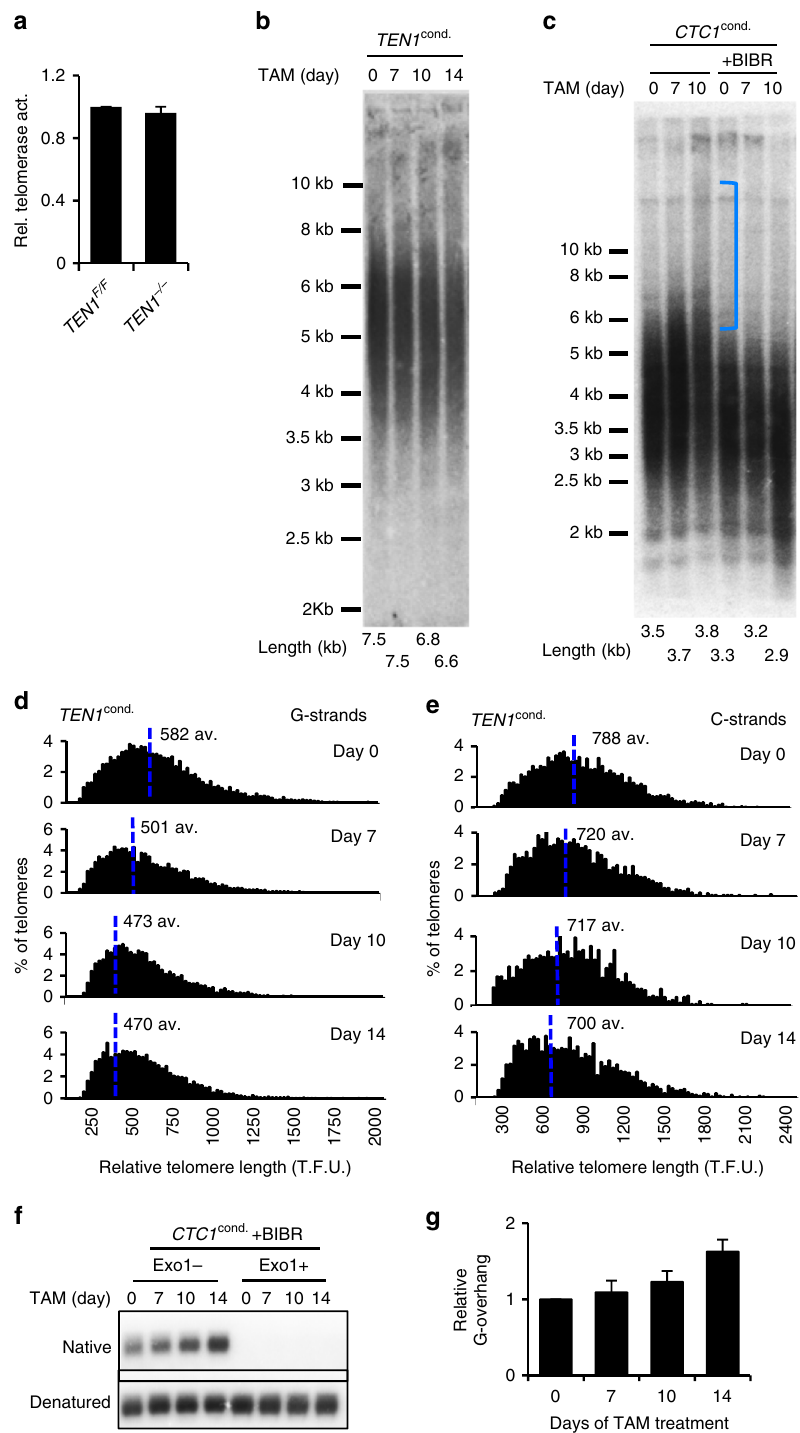
Fig. 3 TEN1 disruption results in telomere shortening without G-strand overextension. a Quanti fi cation of TRAP assay showing telomerase activity in TEN1 conditional cells with/without 14 days tamoxifen treatment. b c Southern blots showing terminal restriction fragments in TEN1 ( b ) or CTC1 ( c ) conditional cells treated with tamoxifen for the indicated times. Mean telomere length is indicated below each lane. c Cells were grown with/or without BIBR1532 for 14 days. Bracket indicates telomere elongation. d e Analysis of telomere length by Q-FISH. Metaphase spreads were hybridized with (C 3 TA 2 ) 3 G-strand probe ( d ) or (G 3 AT 2 ) 3 C-strand probe ( e ). Histograms show distribution of relative telomere lengths expressed as fl uorescence intensity (TFU telomere fl uorescence unit). A minimum of 100 TFU was set as the cut-off. av.; median value, also shown by blue line. >2000 telomeres quanti fi ed per sample. f g G-overhang analysis in CTC1 conditional cells after BIBR1532 treatment. f Gel showing hybridization of TAA(C 3 TA 2 ) 3 probe under native and denaturing conditions. g Quanti fi cation of G-overhang abundance. Signal from CTC1 − / − cells was normalized to that of CTC1 F/F (day 0) cells. Error bars indicate mean ± S.E.M., n = 3 independent